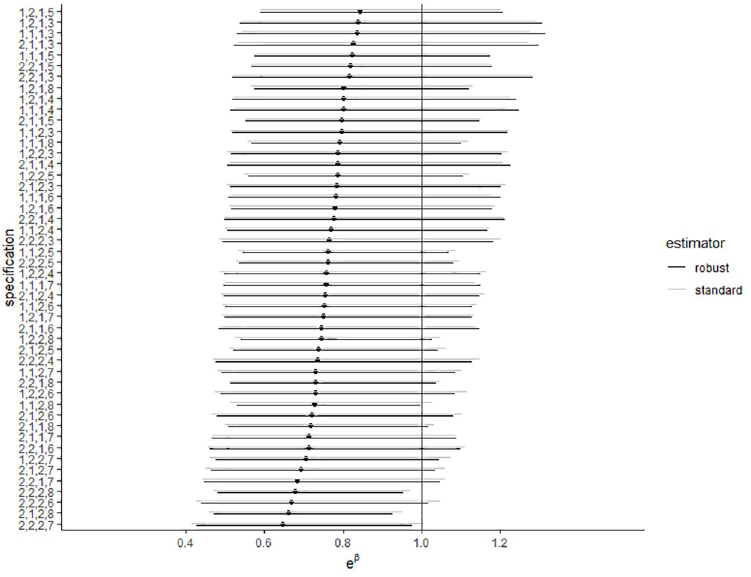
Fig 2. Multiverse analysis of the regression of consistency errors on data sharing in the replication data set. The figure represents the point estimates and 95% confidence intervals for the exponentiated regression coefficients of the predictor shared for all combinations of analytical choices. The vertical line represents the absence of an effect ( e 0 = 1). The choice of variance estimator is indicated in black (robust) or grey (standard). On the y-axis, the other specifications are shown through a four-digit code. Each position refers to a decision and the specific number indicates which option has been chosen. The four decision variables are: (1) natural logarithm of the number of statistics (1 = included in the model as predictor, 2 = included as exposure variable), (2) square root of the mean of the recalculated p -values (1 = included in model, 2 = not included), (3) journal (1 = not included in model, 2 = included), and (4) construction of the data set (3 = replication data, 4 = the selected p -values are less than or equal to .05, 5 = all p - values are selected, 6 = all test statistics are selected, 7 = all test statistics and p -values that are less or equal to .05 are selected, and 8 = all test statistics and all p -values are selected. The main analysis is specification 1,1,1,3 in black.